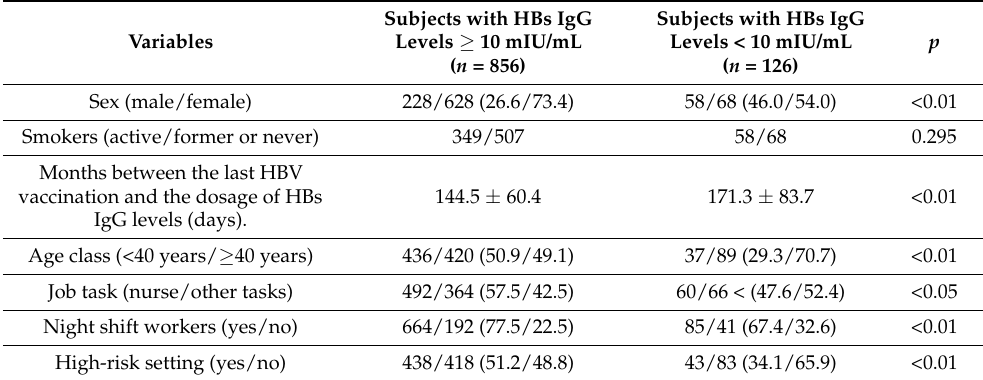
Table 2. Main characteristics of the study population according to HBV titer.